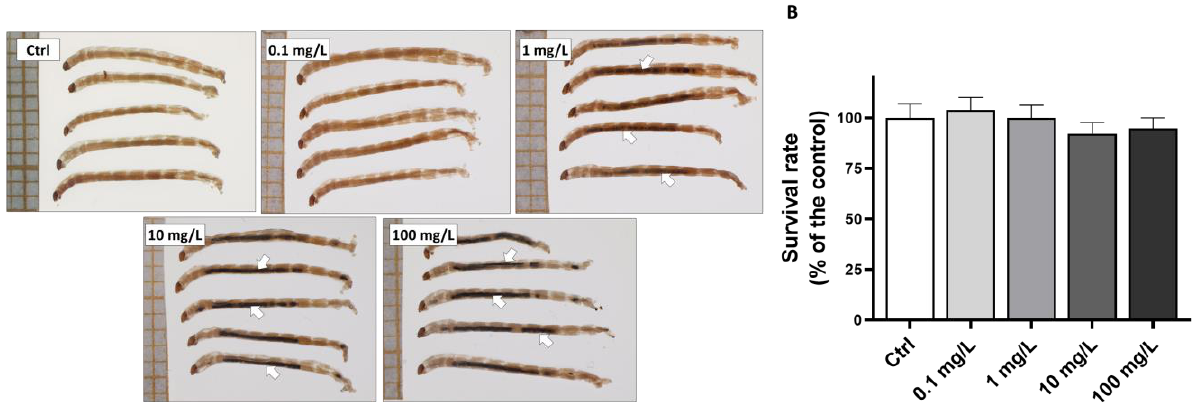
Figure 2. Macroscopic observations of C. riparius whole bodies following 7 days of exposure to GO at concentrations of 0, 0.1, 1, 10 and 100 mg/L ( A ) and associated survival rate ( B ). Arrows indicate the presence of graphene oxide in the digestive tract of exposed chironomids.